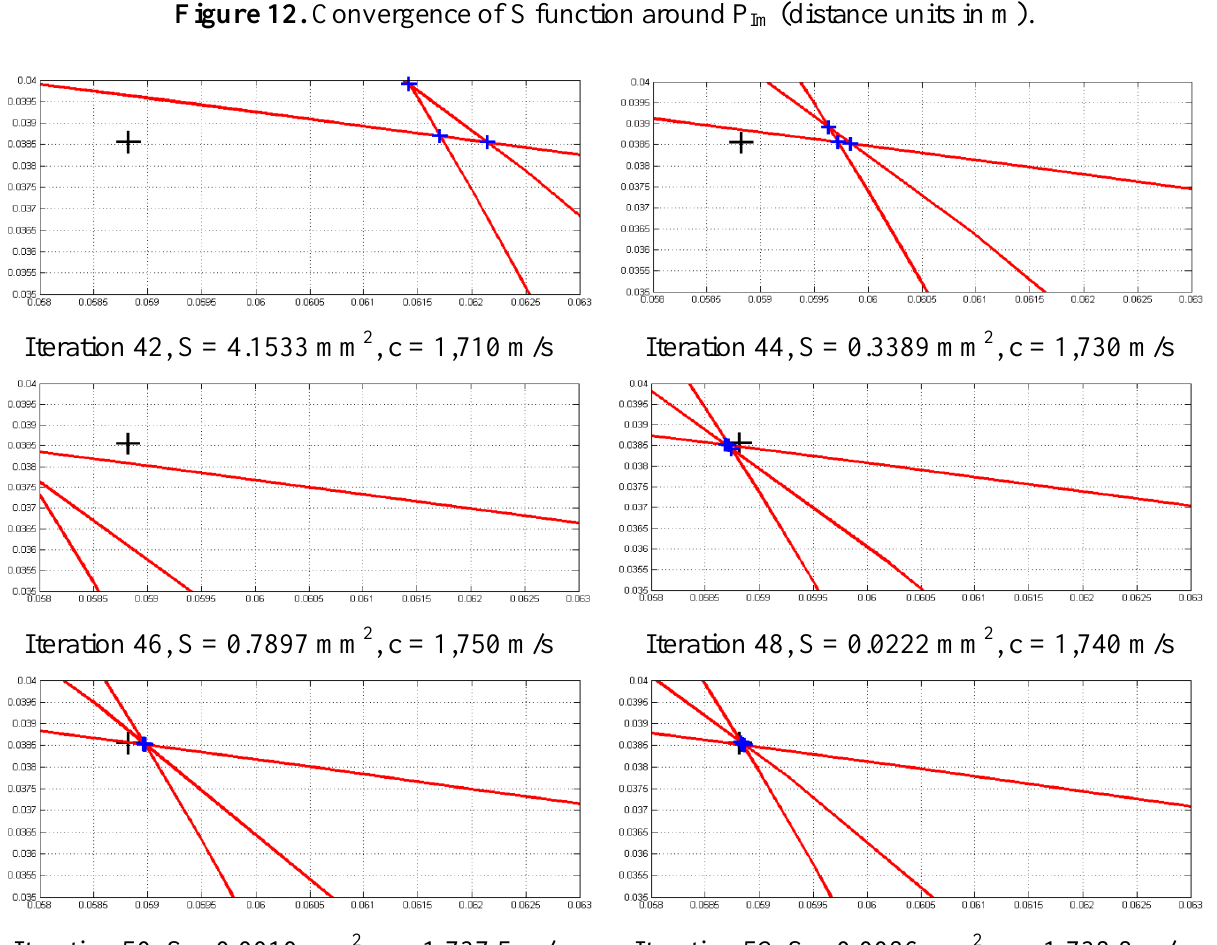
Figure 12. Convergence of S function around P